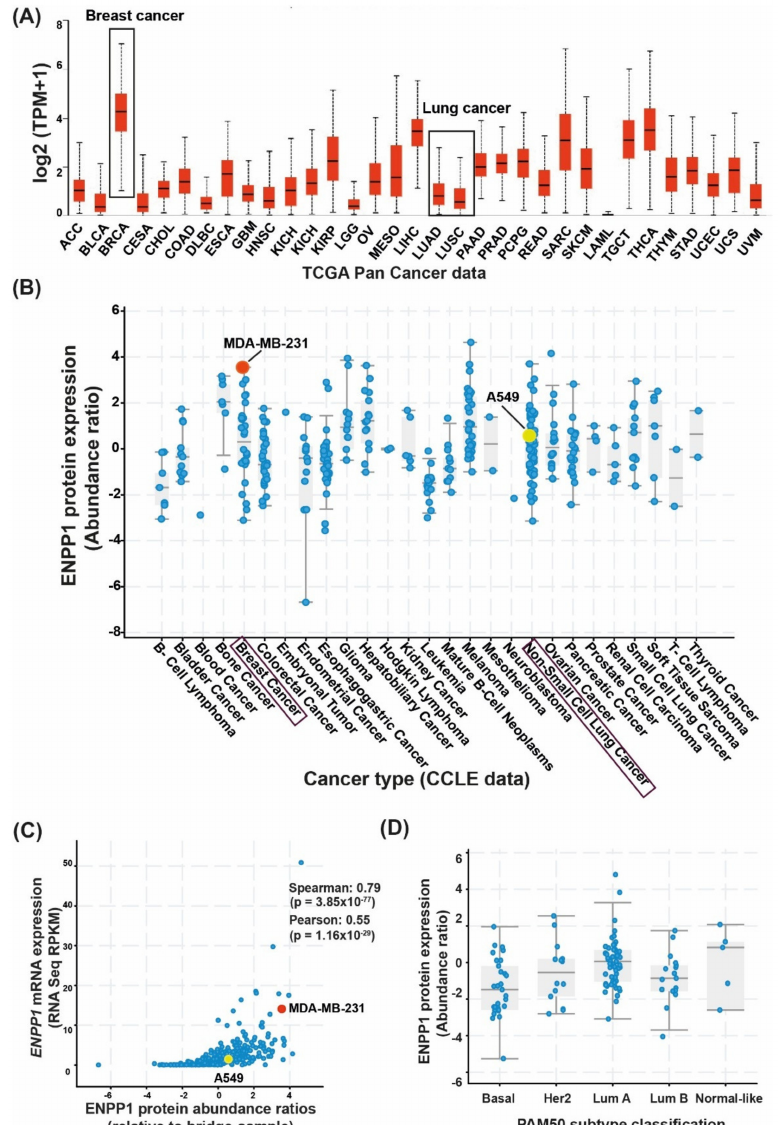
Figure 1. ENPP1 expression across various cancer types. Publicly available sequencing datasets were analyzed to determine the gene and protein expression of ENPP1 across cancer types. ( A ) The Cancer Genome Atlas (TCGA) RNA sequencing data from tumor tissue samples were analyzed using the UALCAN analysis tool. The gene expression of ENPP1 across cancer types has been shown, where breast cancer shows the highest expression (4.27 log2(TPM+1)). ( B ) Protein abundance of ENPP1 across cancer cell lines. The data were acquired from the CCLE database and analyzed through cBioPortal. MDA-MB-231 (triple-negative breast cancer cell line) shows an abundance ratio of 3.55 (ratio with adjacent normal). A549 (lung adenocarcinoma) had an abundance ratio of 0.58. ( C ) Pearson’s correlation analysis showed the correlation between mRNA and protein expressions of ENPP1. The mRNA expression levels are positively correlated with the protein expression across all cancer cell lines (r = 0.55; p = 1.16 × 10 − 29 ). MDA-MB-231 and A549 cell lines are highlighted in red and yellow, respectively. ( D ) The PAM50-classified breast cancer samples [35] have been analyzed to depict the levels of ENPP1 protein abundance across the molecular